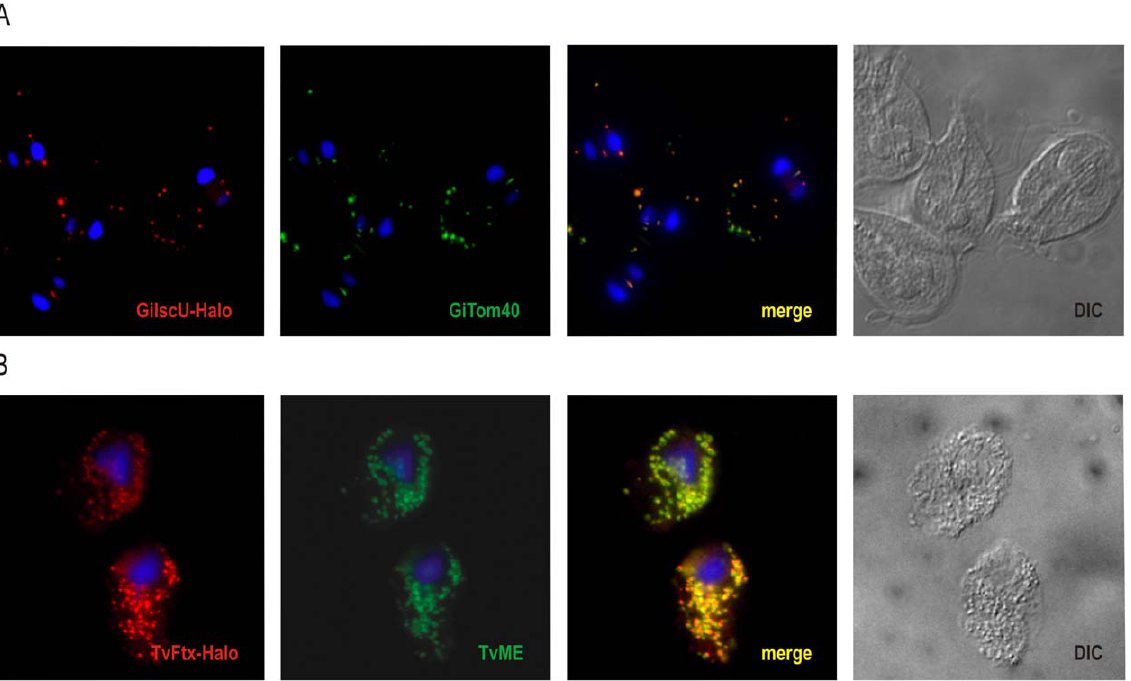
Figure 2. Mitosomal and hydrogenosomal localization of HaloTagged proteins. Immunofluorescence analyses of G. intestinalis and T. vaginalis transformants expressing GiIscU-Halo and TvFtx-Halo fusion, respectively. Cells were incubated with TMR-Halo ligand (red), washed and fixed for immunofluorescence analysis. A)TMR-Halolabeled G.intestinalis cells werefixed and labeled by anti-Tom40specific polyclonalantibodies(green). B) TMR- Halo labeled T. vaginalis cells were fixed and decorated by anti-malic enzyme specific polyclonal antibodies (green). Nuclei were stained with DAPI